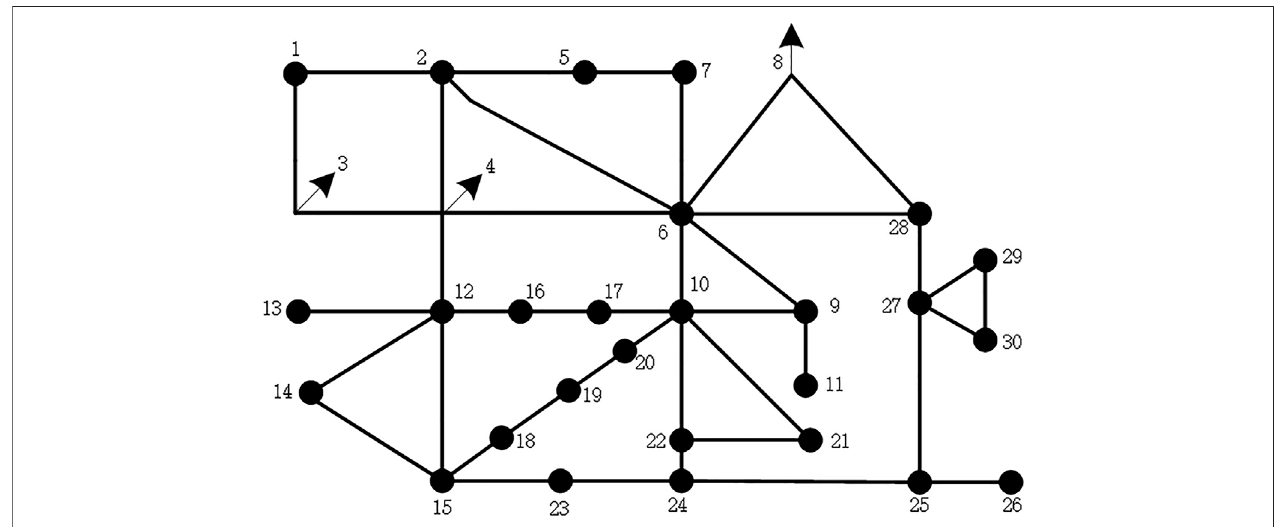
FIGURE 4 | Node diagram of regional power